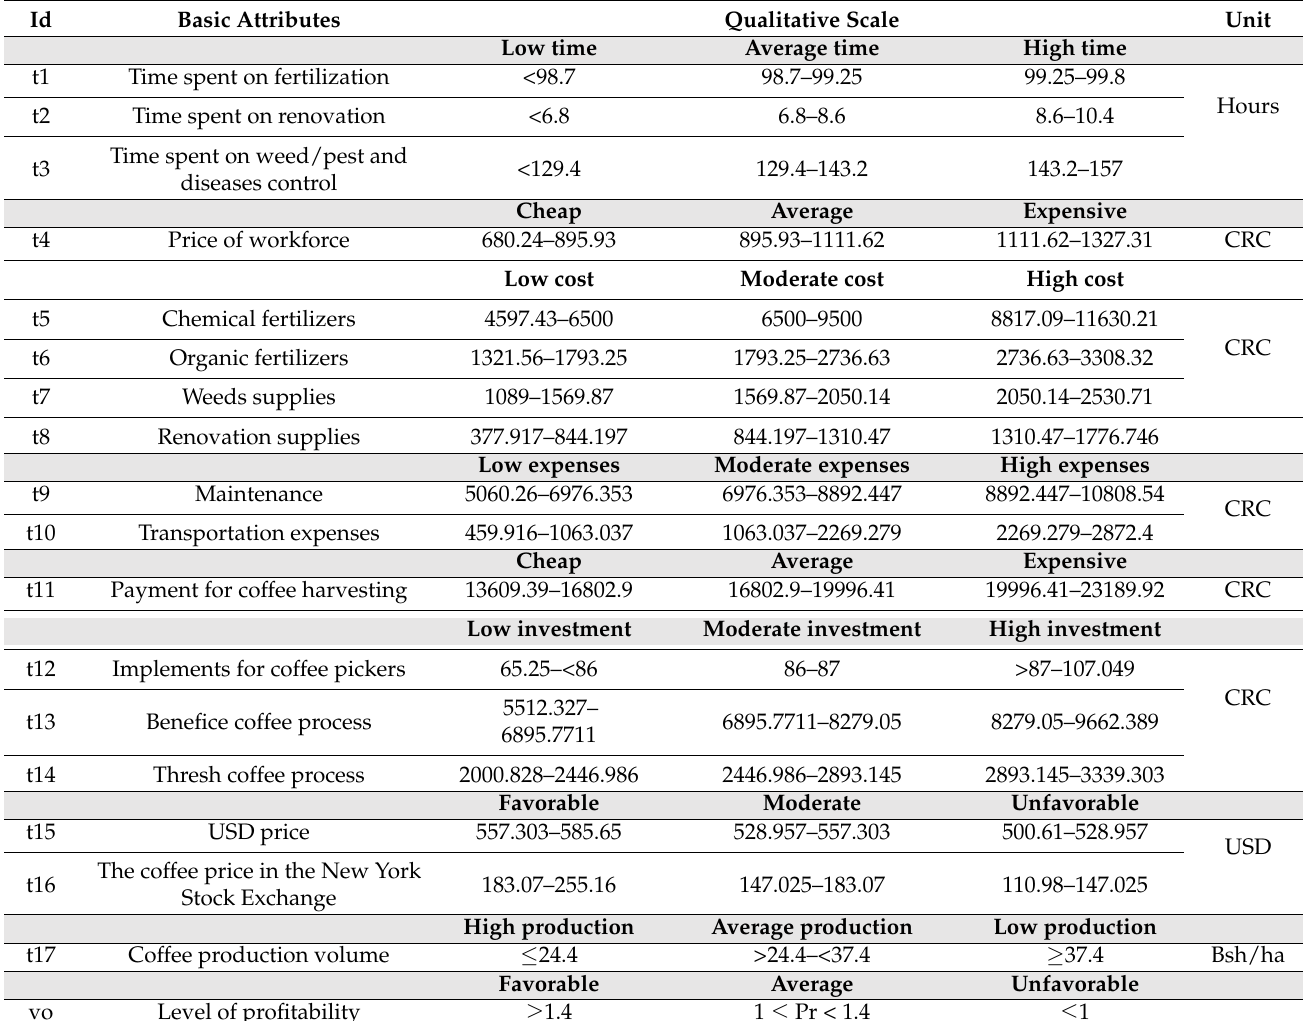
Table 4. Scales definition for the set of HPM-Coffee basic attributes. Grey cells: qualitative scales defined by the panel of experts to HPM-Coffee. White cells: meaning by qualitative value (i.e., ranges) determined by a group of local coffee growers with the respective